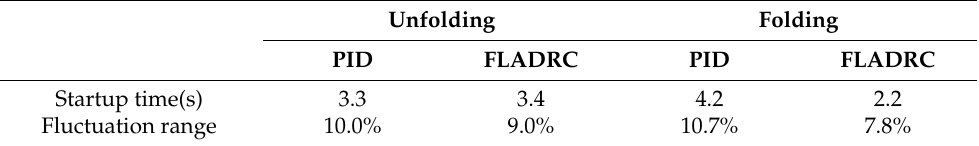
Table 4. Assessment indices of cylinder #2 motion control using PID and FLADRC.